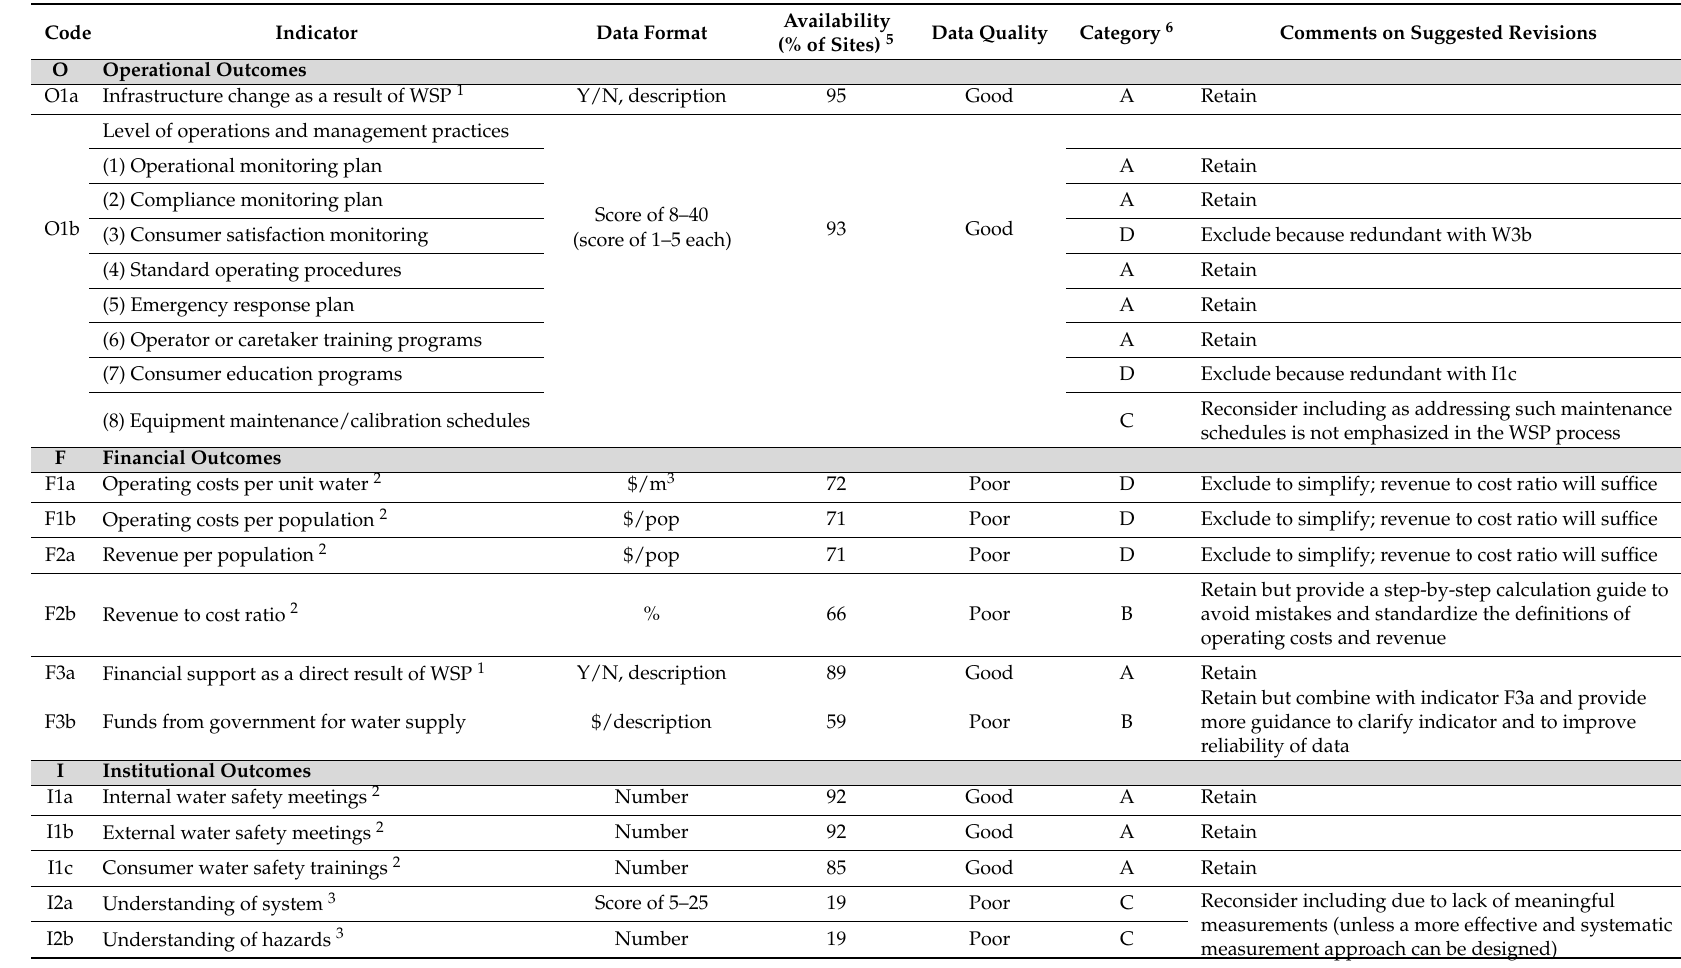
Table 2. Outcome and impact indicators (all are site-level, except policy indicators, which are country-level). For each indicator, data availability (at both baseline and follow-up), data quality, and suggestions for revising the impact assessment framework are reported. On the basis of these recommendations and other inputs, WHO will publish a separate document detailing revised indicators and associated data collection